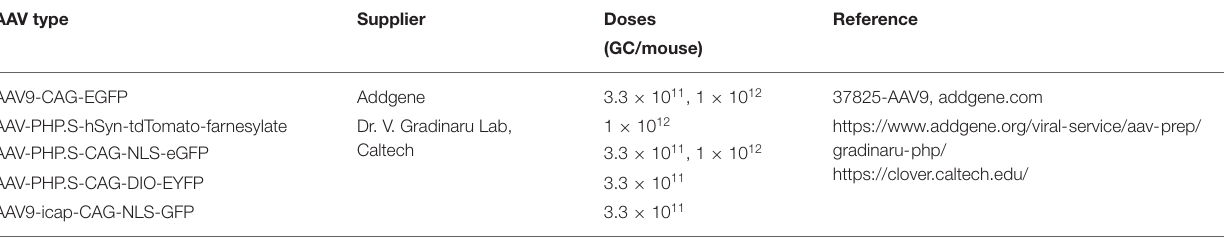
TABLE 1 | AAV types, doses and suppliers.